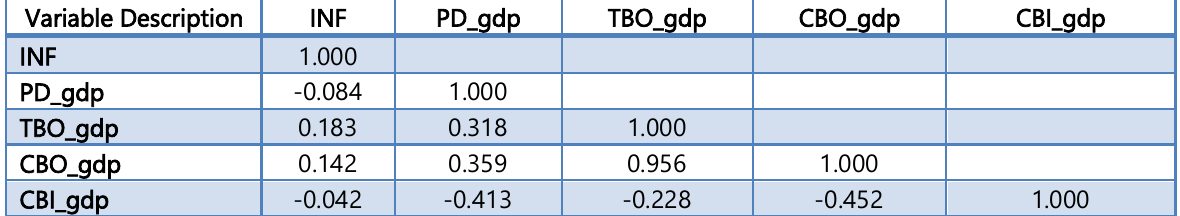
Table 3: Correlation Statistics (Source: Author’s calculation) Variable Description INF PD_gdp TBO_gdp INF